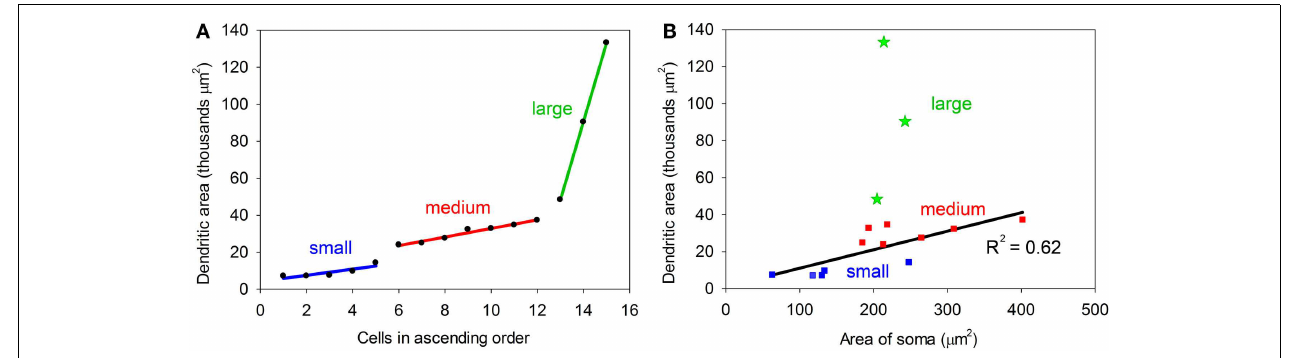
FIGURE 3 | (A) Plot showing the dendritic areas of the 15 labeled cells arranged in ascending order. Regression lines have been plotted for each of the three groups which have been defined by a break in the slope of the plot.